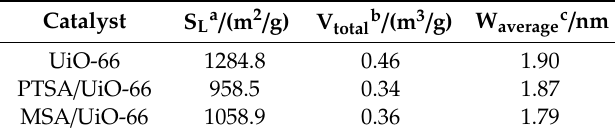
Table 1. Physicochemical properties of the prepared catalysts.